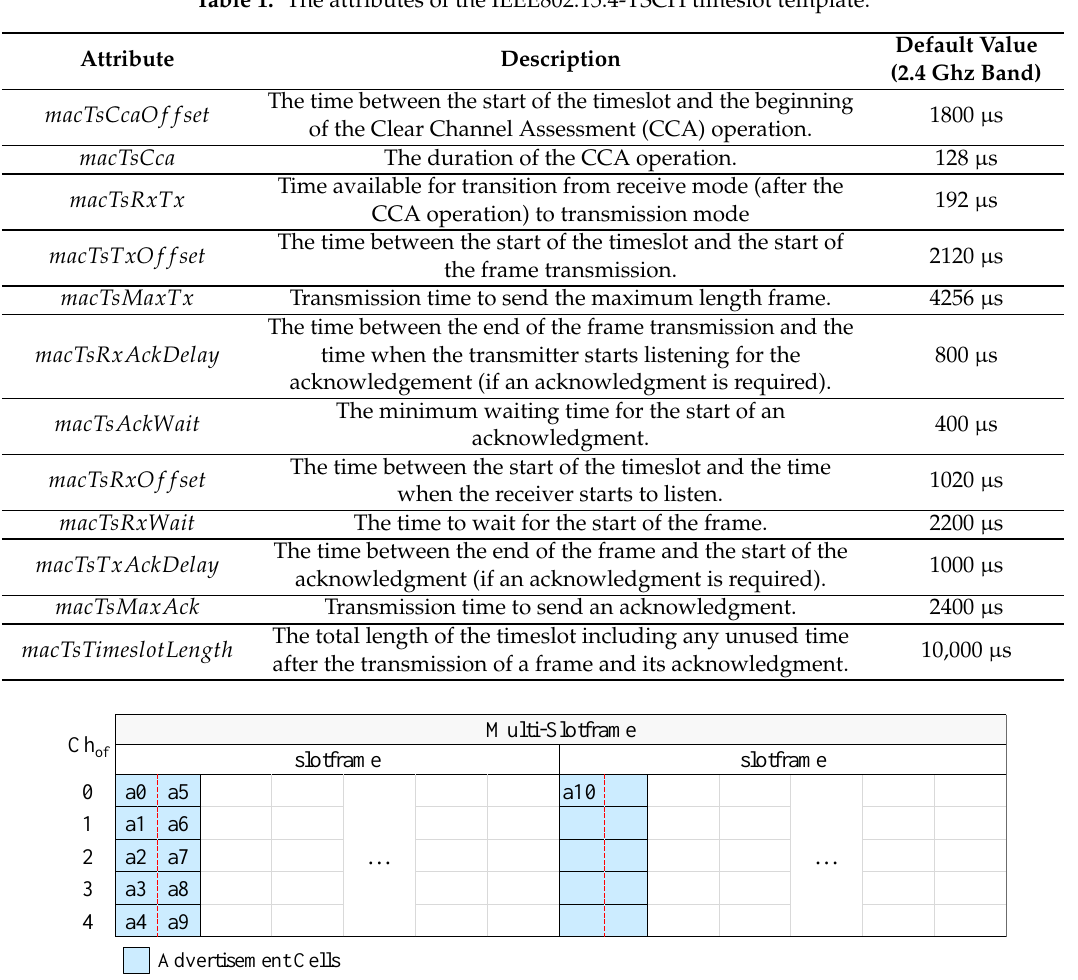
Figure 10. CFAS using vertical indexing and ATP in the case where there are 2 subslots per advertisement slot, 5 available channels, the identifiers of the advertisers are consecutive and start from 0, S = 2 and A s = 1. The dashed lines separate the subslots of the advertisement slots. In ATP, an advertiser transmitting in a sublot calculates the related channel using Equation (1), where ASN is that of the slot which the subslot belongs to. Therefore, the cells that are created by the sublots of an advertiserment slot in the same channel offset are mapped to the same